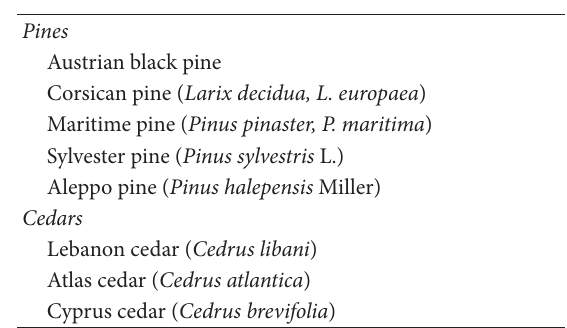
Figure 2: Aeromediated contact papulo-urticarial eruption due to setae of pine